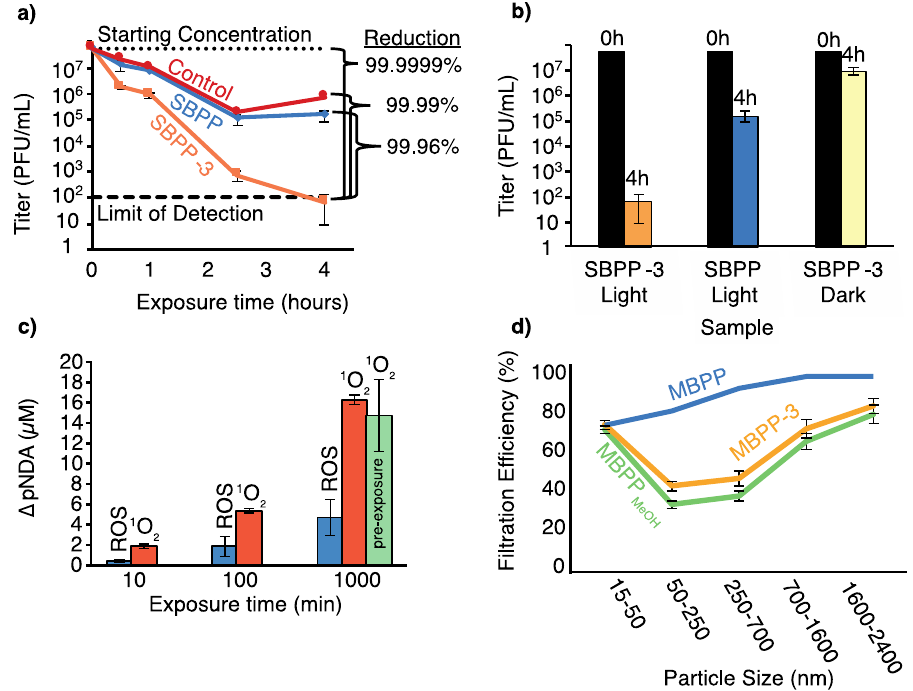
Figure 3. ( a ) Log 10 Reduction of PFU/mL active virus vs. exposure time to visible light against the control (empty well), SBPP , and SBPP-3 ; ( b ) Log 10 Reduction of PFU/mL active virus at 4 h against SBPP-3 and SBPP with and without light in comparison to the starting virus concentration (0 h); ( c ) Relative change in scavenger pNDA concentration comparing quantities of 1 O 2 and ROS produced from 1 mg of SBPP-3 during exposure to white light. Pre-exposure is an analogous 1 O 2 scavenging experiment with SPBB-3 after a exposure to 30,000 lx of white light for 4 days. A larger value of ΔpNDA indicates more of that species produced; ( d ) Filtration efficiency of MBPP , MBPP MeOH , and MBPP-3